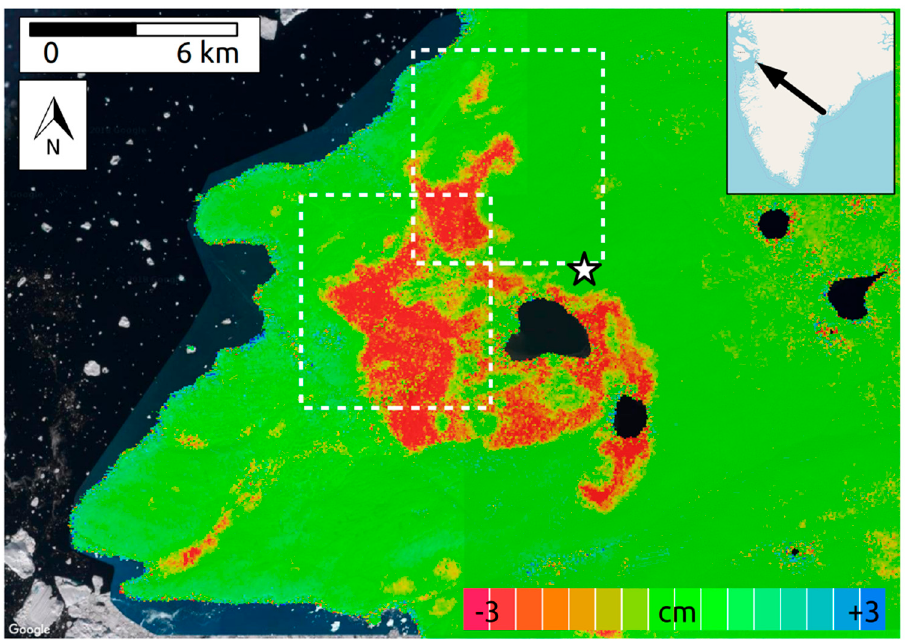
Figure 5. Subsidence map over Ilulissat (Greenland) from Sentinel-1 InSAR from 2 June to 18 September 2016. The white star indicates the reference position, the white boxes the enlargements of Figures 6 and 7. Remote Sens. 2018 , 10 , x FOR PEER REVIEW